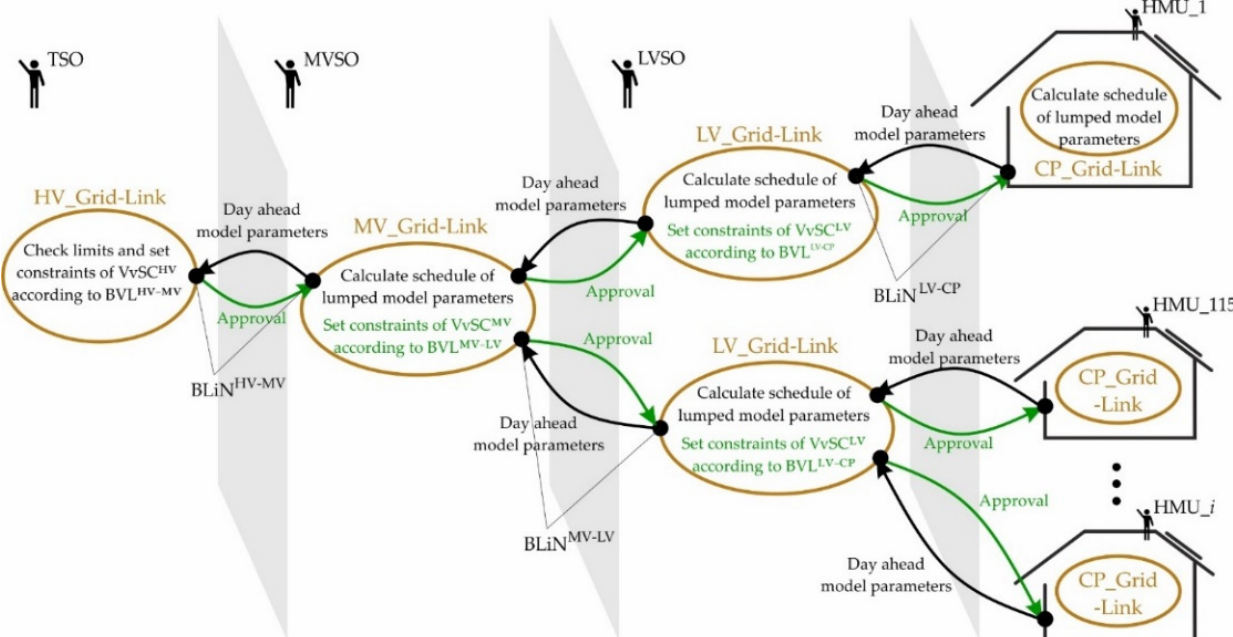
Figure 20. LINK -based day-ahead BVL scheduling chain.